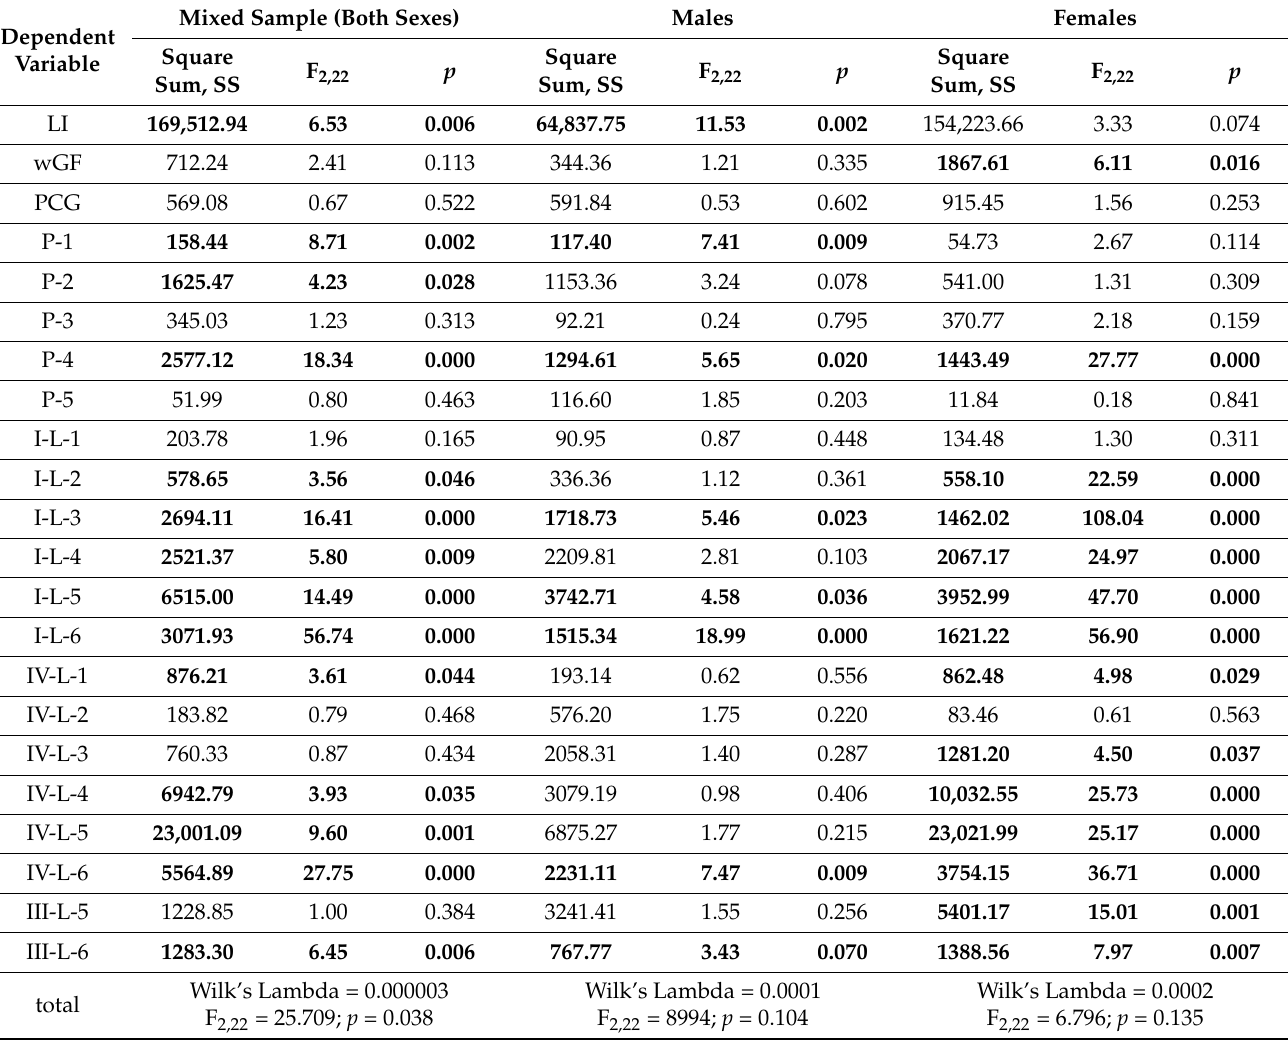
Table 3. The ANOVA and MANOVA (total line) results of morphological structures between three Myanmaratax subgen. nov. species (genus Unionicola ) based on linear dimensions (statistically different values are in bold). Abbreviations are given in the “Taxonomic account” section of the